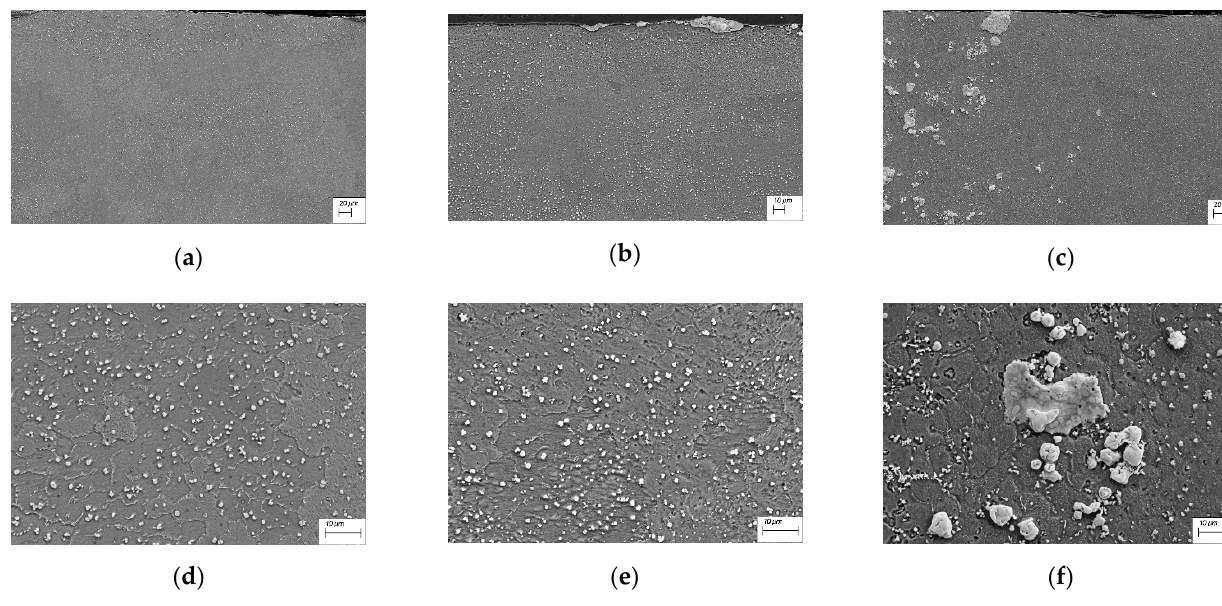
Figure 5. Copper surface layer after laser surface alloying with Cr–WC powder, laser power 2.0 kW,